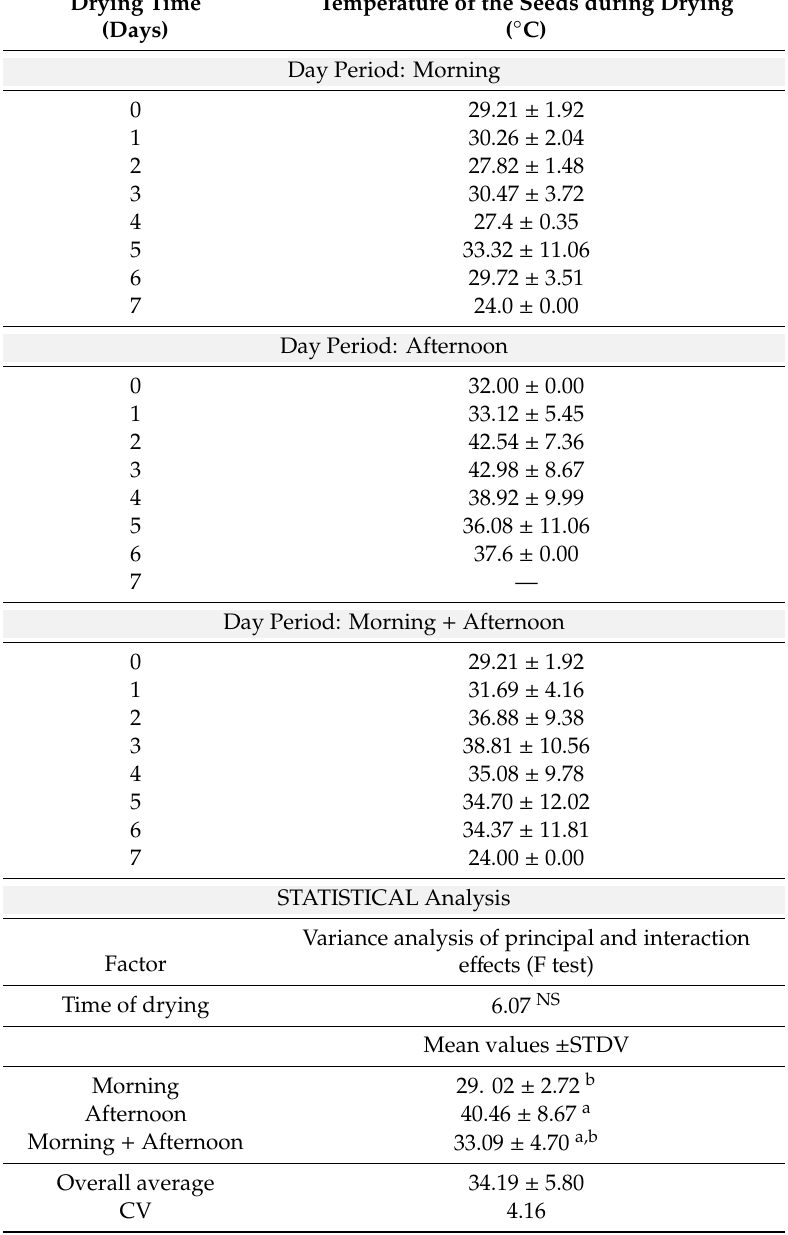
Table 2. Average values and standard deviations (mean ± STDV) from 3 analytical measures per batch (lot) of 5 lots and 2 sampling periods per each day (morning and afternoon) for the temperature parameters of the seeds throughout 6–7 days (depending on the evolution of the process) of controlled drying of cupuaçu seeds : average in morning; average in afternoon; and overall average (morning and afternoon). The initial, after fermentation, and after drying weights were, respectively: 100.0, 77.65, and 37.65 kg in lot 1; 100.0, 83.0, and 41.8 kg in lot 2; 100.0, 81.0, and 39.2 kg in lot 3; 100.0, 103.0, and 53.3 in lot 4; and 100.0, 82.0, and 39.5 in lot 5. Statistical analysis: F-tests Tukey post-hoc tests at 5% probability ( p ≤ 0.05) for the multiple comparison of mean di ff erences. Numbers from the same column with the same superscript letter are not significantly di ff erent, as obtained by the Tukey’s test ( p ≤ 0.05). NS = Not significant; * = Significant di ff erence ( p ≤ 0.05); ** = Significant di ff erence ( p ≤ 0.01); CV = Coe ffi cient of